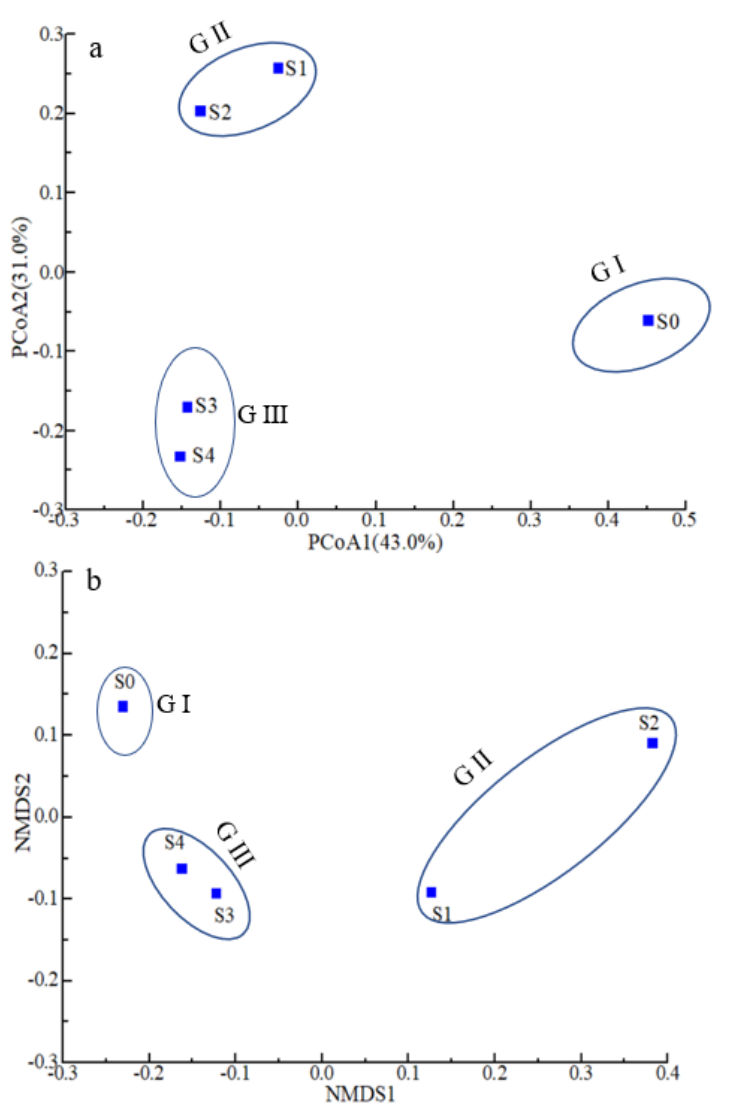
Figure 6. Plots generated from PCoA ( a ) and NDMS ( b ) based on the OUT with unweighted